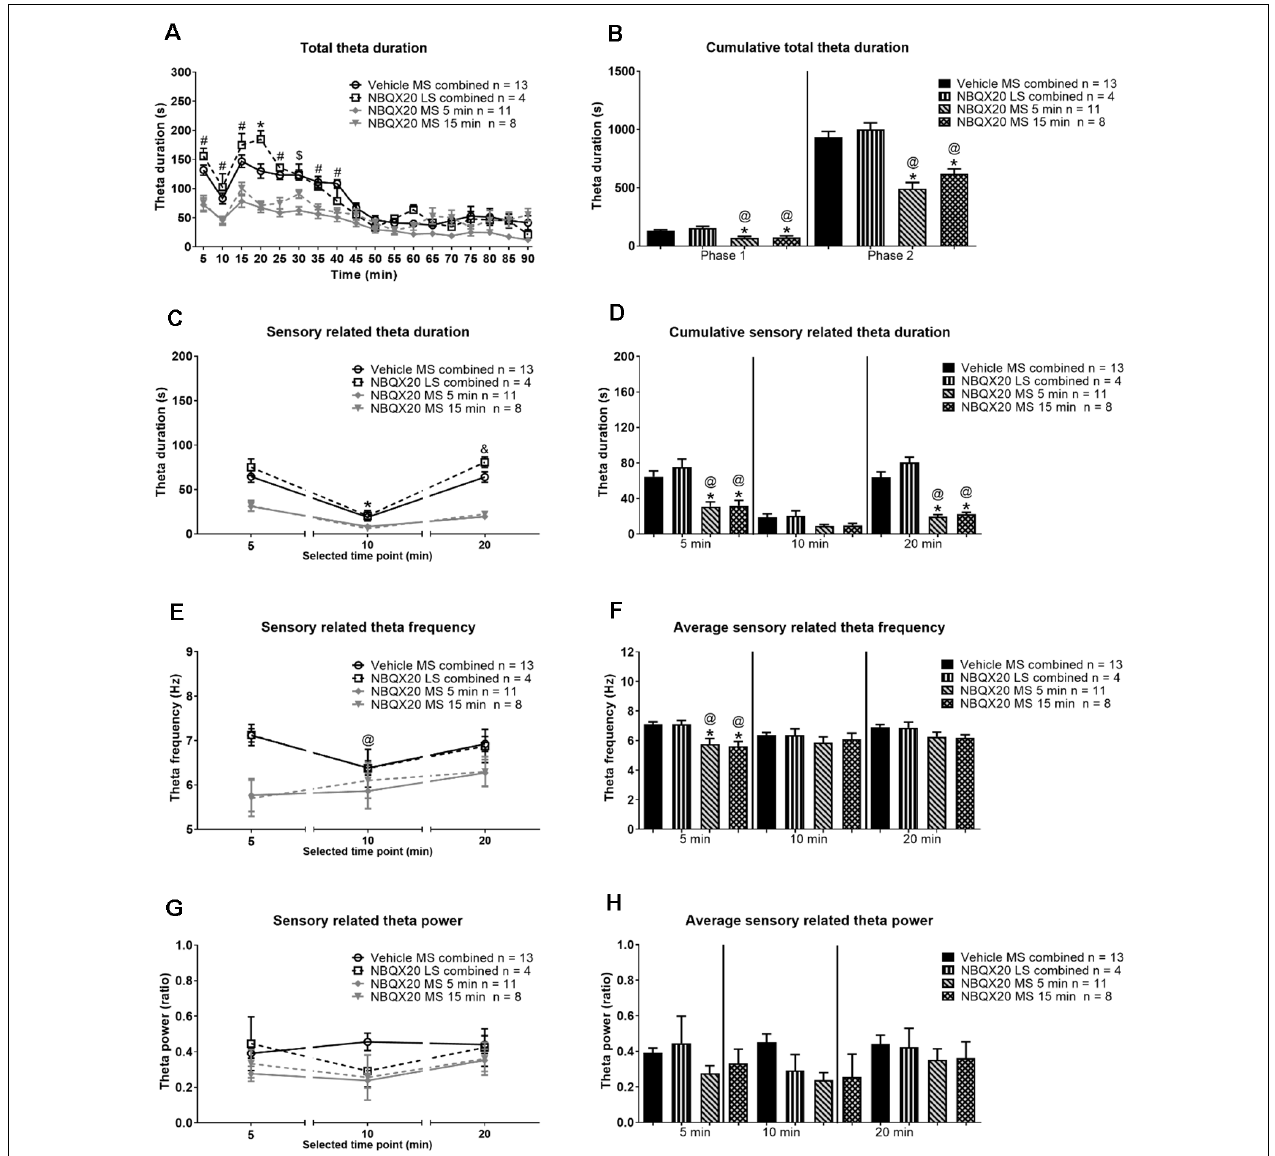
FIGURE 8 | Intraseptal microinjection of NBQX attenuates formalin-induced hippocampal theta activity. The figure illustrates the effect of NBQX microinjection (20 µ g/ µ l, 0.5 µ l; ‘NBQX20’) on formalin-induced hippocampal theta wave activity. This figure is developed as in Figure 7 . The left panels show the time course of the duration of total theta wave activity (A) , and the duration (C) , FFT theta peak frequency (E) , and FFT theta peak power (G) of sensory behavior-related theta wave activity at selected time points. The corresponding panels on the right are histogram representation of the parameters. The time points illustrated in (C–H) correspond to peaks of behavior and theta activation in Phase 1 (0–5 min) and Phase 2 (16–20 min) of the formalin test. The time point 10 min corresponds to the interphase (6–10 min; relatively quiescent phase) of the formalin test. The ‘Total theta duration’ reflects total theta activity which is inclusive of sensory-related theta and is presented in 5 min blocks (A) or the cumulative duration during Phase 1 (0–5 min) or Phase 2 (11–60 min) (B) . While ‘sensory theta’ is theta stretches that were observed in parallel with the formalin-induced flinching or licking behavior (C–H) . The duration and frequency of sensory theta (C,E) were lower at interphase suggesting a biphasic pattern. Further, microinjection of NBQX into MS, but not LS, affected all theta parameters except theta power. Data are mean ± S.E.M. Significant difference ( p < 0.05): Time course: (A) *vehicle vs. NBQX20 MS 5 min, NBQX20 MS 15 min, and NBQX20 LS combined, # vehicle vs. NBQX20 MS 5 min and NBQX20 MS 15 min, $ vehicle vs. NBQX20 MS 5 min; (C,E) *vs. 5 min for vehicle, NBQX MS 5 min, NBQX MS 15 min, and NBQX LS combined, and vs. 10 min for vehicle and NBQX LS combined, @ vs. 5 min for vehicle, two-way RM ANOVA followed by Bonferroni post hoc test. Histograms: *vs. Vehicle and @ vs. NBQX20 LS combined, one-way ANOVA followed by Newman-Keuls post hoc